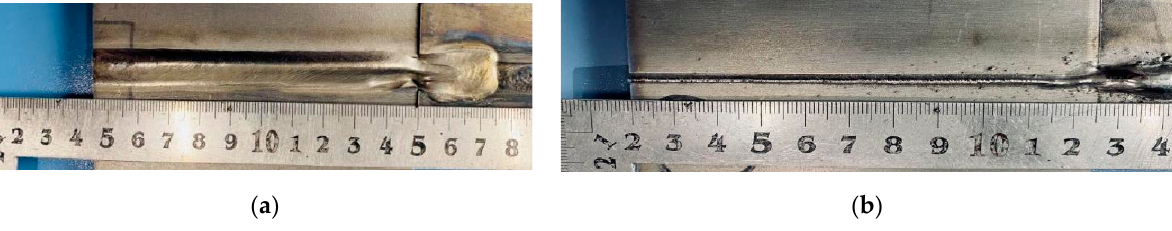
Figure 8. Weld surface morphology: ( a ) positive forming and ( b ) back forming.